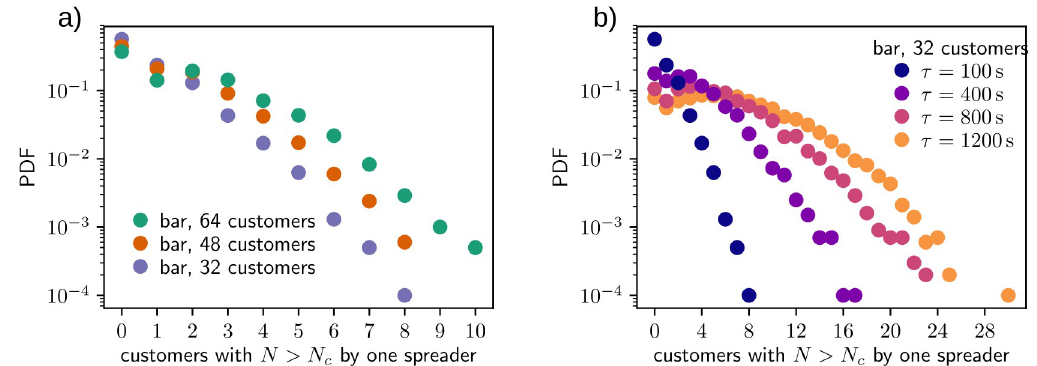
Fig 4. Distribution of the number of customers with critical exposure N > N simulations with τ = 100 s and varying amount of customers and (b) from bar simulations with 32 customers and varying ventilation conditions via parameter τ